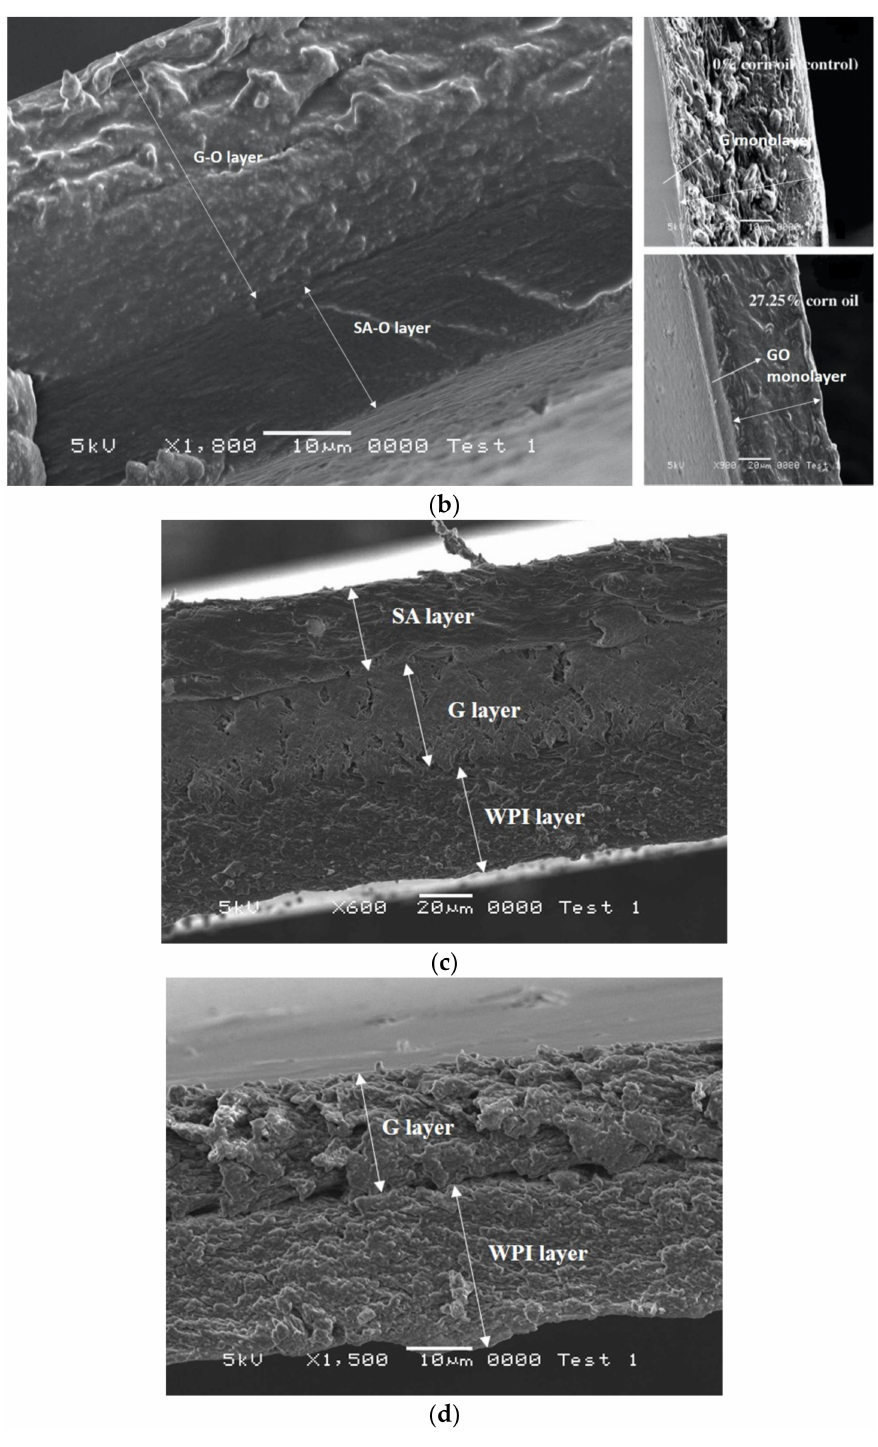
Figure 3. ( a ) Cross-section of G-SA laminated film and ( b ) cross-section comparison of GO-SAO laminated film (on the left, this study), G monolayer film and GO film with 27.25% corn oil (on the right) [20]. ( c ) Cross-section of SA-G-WPI laminated film. ( d ) Cross-section of G-WPI laminated